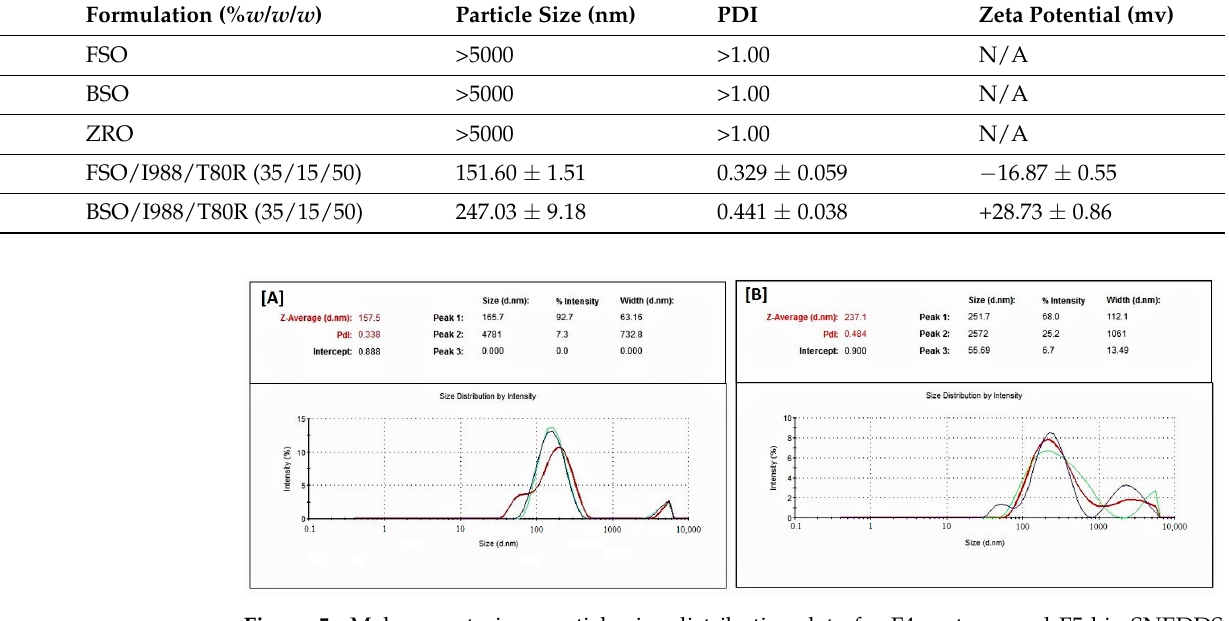
Figure 5. Malvern zetasizer particle size distribution data for F4 systems and F5 bio-SNEDDS; ( A ) FSO/I988/T80R (35/15/50) % w / w / w and ( B ) BSO/I988/T80R (35/15/50) % w / w / w ,